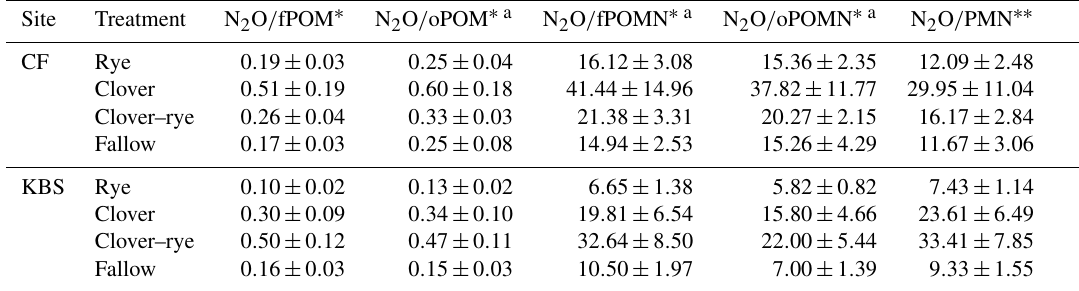
Table 3. Mean ± standard error for ratios of grams of N 2 O per gram of POM and grams of N 2 O per kilogram of PMN by treatment and site. P values are indicated as follows: ∗ < 0 . 05 and ∗∗ < 0 . 001 for differences between treatments and a < 0 . 05 for differences between sites.